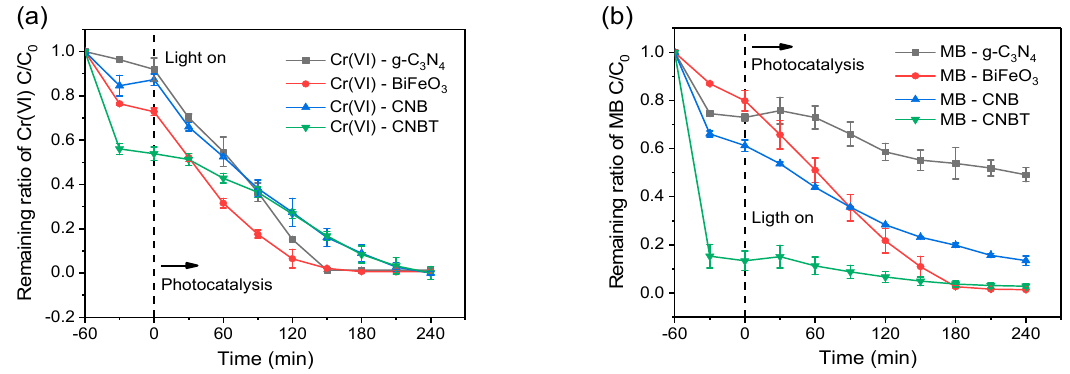
Figure 9. Effects of different kinds of materials on Cr(VI) ( a ) and MB ( b ) reduction by g-C 3 N 4 , BiFeO 3 , CNB, and CNBT under visible light irradiation when Cr(VI) mixed with MB: C 0Cr(VI) = 5 mg/L, C 0MB = 20 mg/L, m/V = 2.5 g/L, pH = 2.0. ( − 60–0 min: Adsorption process, 0–240 min: Photocatalysis process).